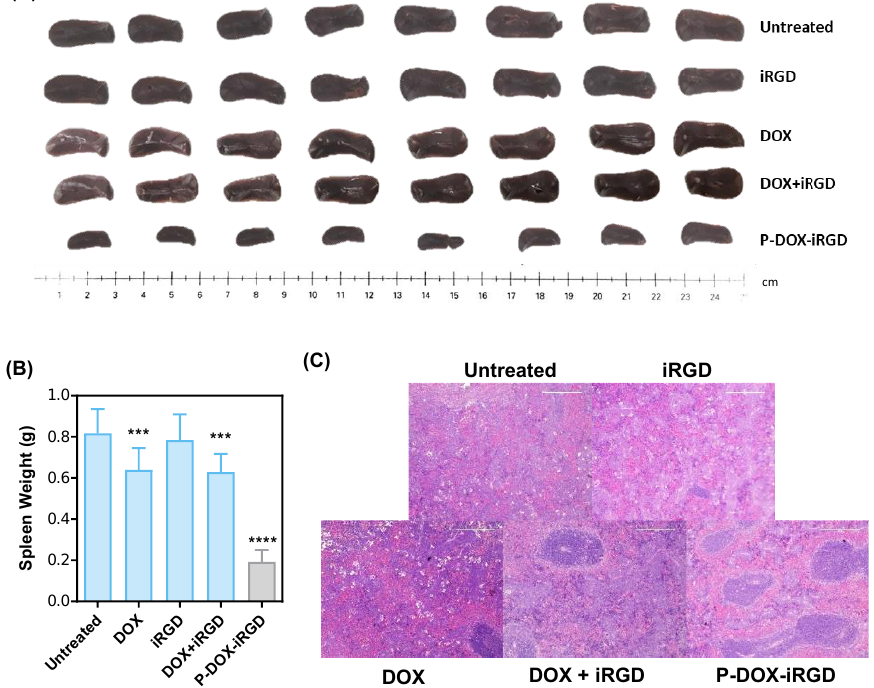
Figure 6. Reduction of tumor-induced splenomegaly. ( A ) Representative images of spleens on day 26. ( B ) Weight of spleens on day 26. ( C ) Hematoxylin and eosin stains (H&E) of spleens. Data are expressed as mean ± SD *** p < 0.001, and **** p < 0.0001 Scale bar = 200 μm